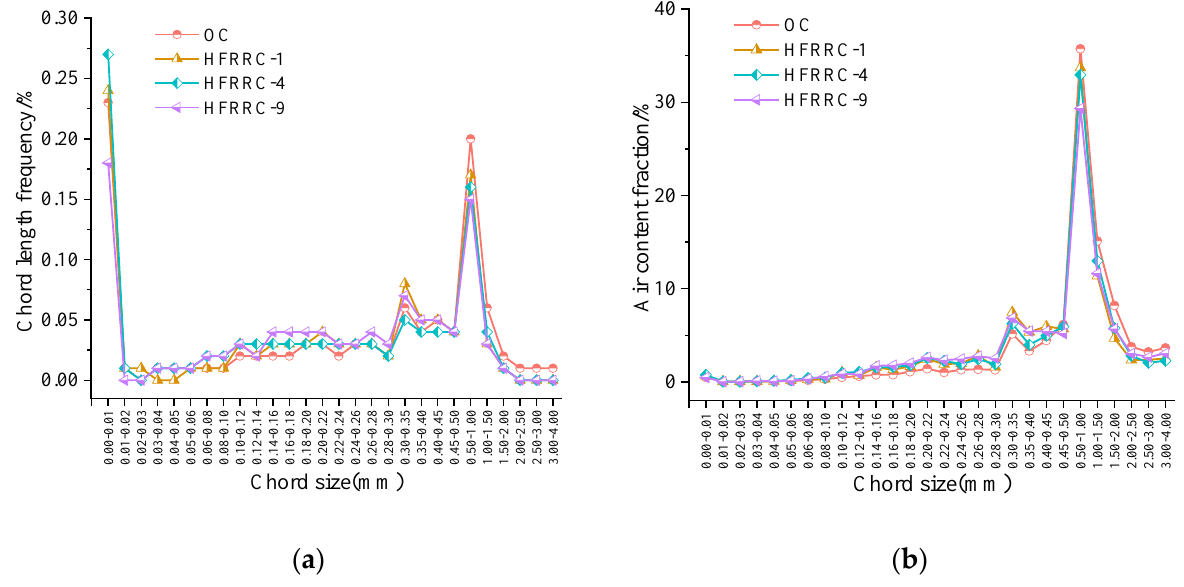
Figure 15. The distribution of ( a ) chord length frequency; ( b ) air content fraction.